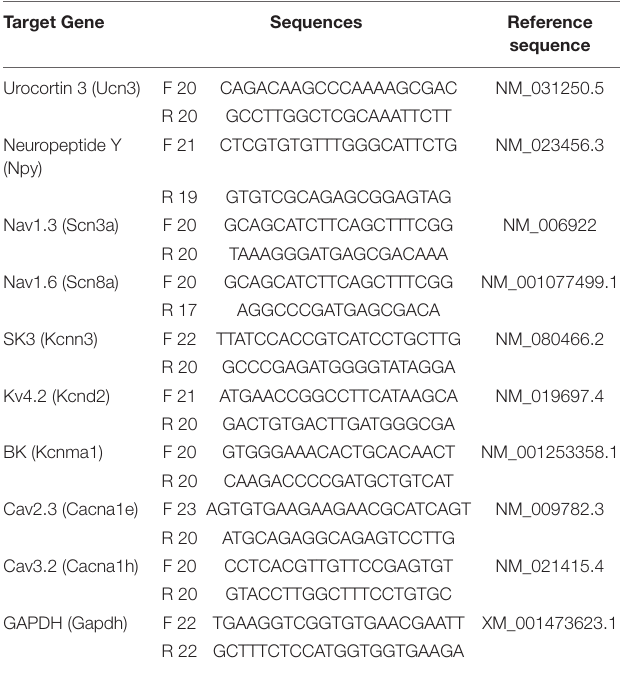
TABLE 1 | The sequences of primers used in quantitative real-time PCR (qRT-PCR). Target Gene